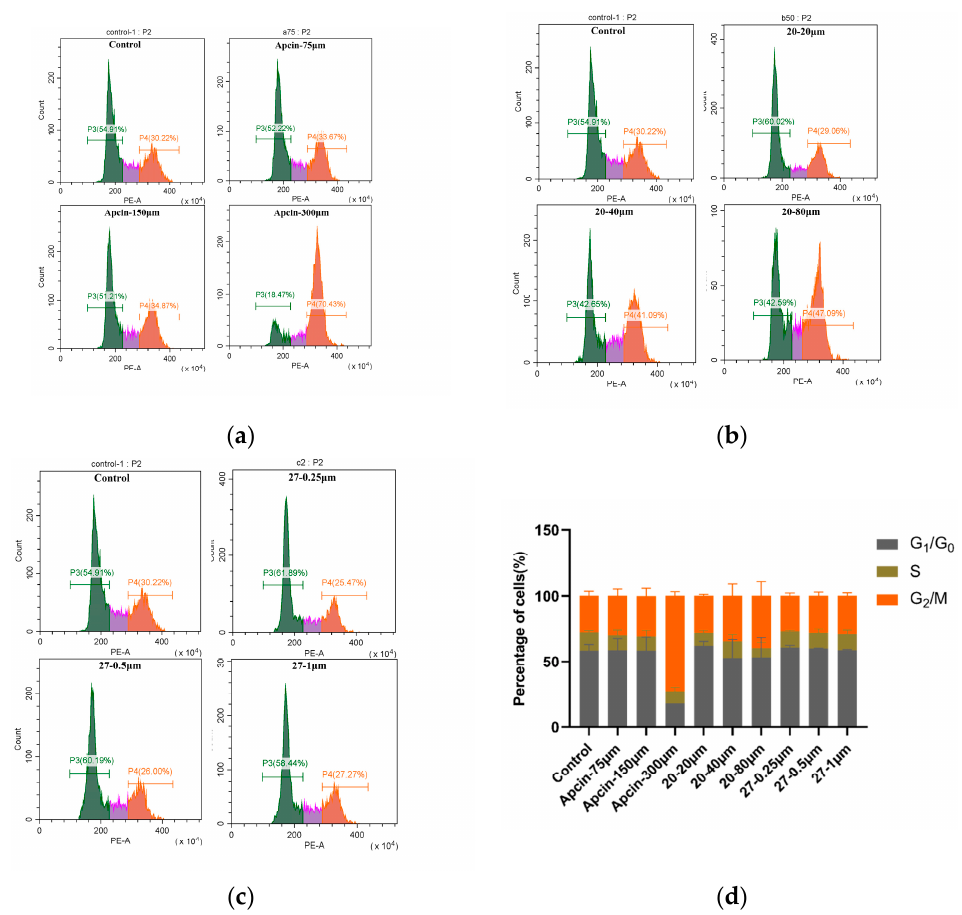
Figure 6. ( a – c ) Cells were treated with Apcin, compound 20, and compound 27 for 24 h. Cell lysate was analyzed to investigate whether the compound blocked mitotic exit in Hela cells. ( d ) Quantitative results are illustrated.